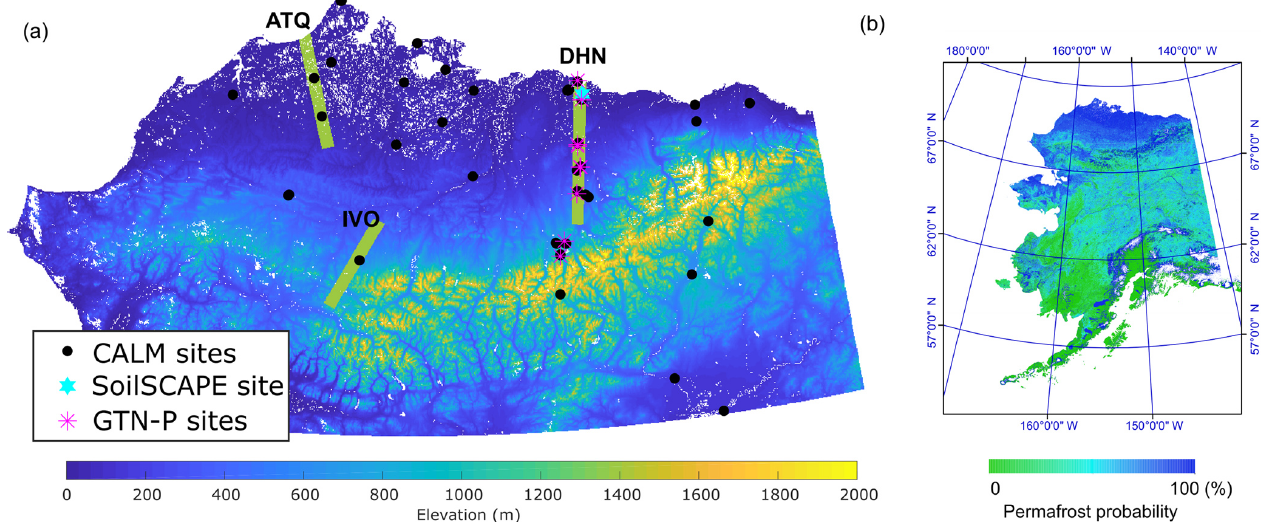
Figure 2. (a) The study area (Arctic Alaska, > 66 . 55 ◦ N) used for the soil model simulations and the locations of in situ sites used for model calibration and validation; (b) an Alaska permafrost probability map (Pastick et al., 2015) is also shown, indicating higher permafrost occurrence in Arctic Alaska. The in situ sites include the Prudhoe Meadow SoilSCAPE site, GTN-P soil temperature sites and CALM ALT sites. Airborne P-band radar data (denoted by green lines) were obtained in late August and early October in 2014 and 2015. Another radar flight line was collected over the Barrow area (not shown) but was not included in this analysis due to a large percent of surface water in this